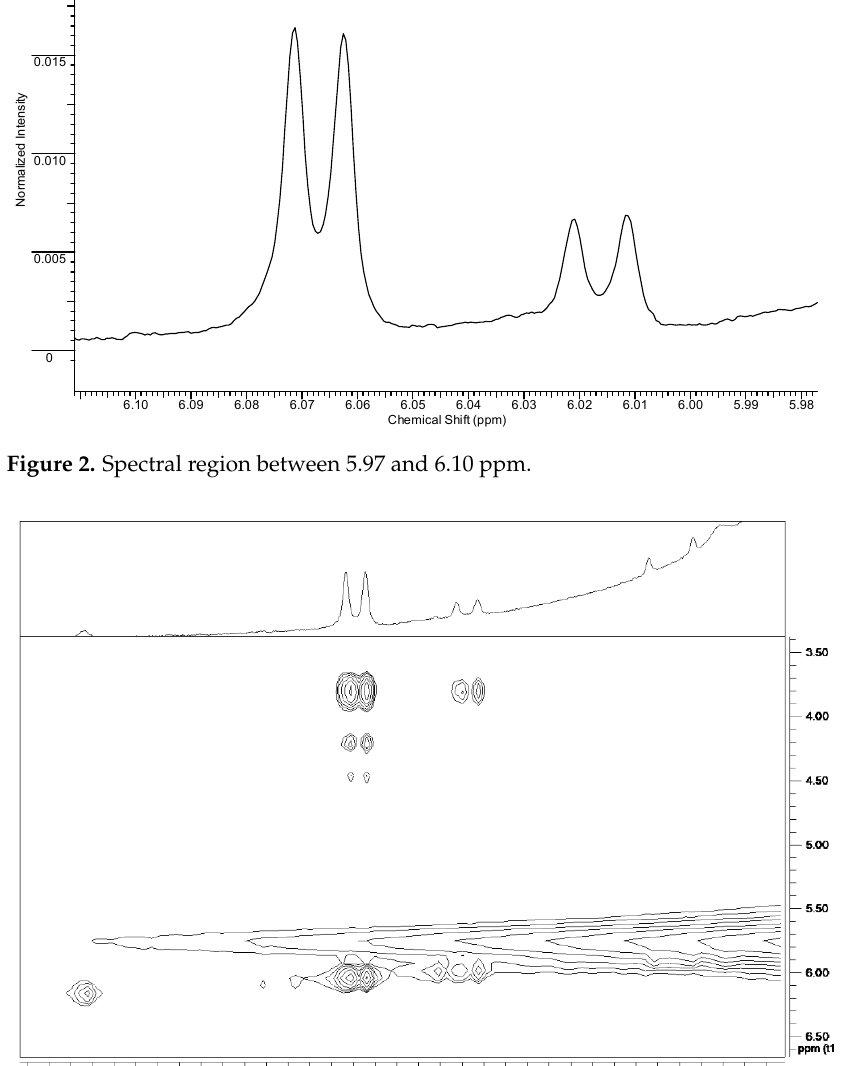
Figure 4. Spectral region between 8.50 and 8.80 ppm. On the basis of literature data [35] and HSQC experiments (Figure 4), it was possible to univocally identify the RBV resonances, with the H-5 proton resonating at 8.76 ppm and the corresponding H-1 ′ of the ribosyl moiety resonating at 6.07 ppm. Concerning the ribosyl moiety whose anomeric proton resonates at 6.01 ppm, on the basis of the relative integrals between this proton and triazolic ring one, it is possible to univocally assign the TR-COOH H-5 to the resonance at 8.65 ppm. The singlet resonating at 8.53 ppm can be attributed to T-CONH 2 on the basis of the HSQC experiment (Figure 5), since the corresponding carbon resonance (150 ppm) is closer to the one of RBV (150 ppm) than that of TR-COOH, which resonates at 149 ppm. The similarity in the carbon chemical shift indicates that the resonance structures of the two rings are rather similar and this is only possible if the carboxyl group is substituted with an amidic group. The absence of the ribosyl moiety mainly influences the proton chemical shift, which is 0.23 ppm lower compared to RBV. 8.80